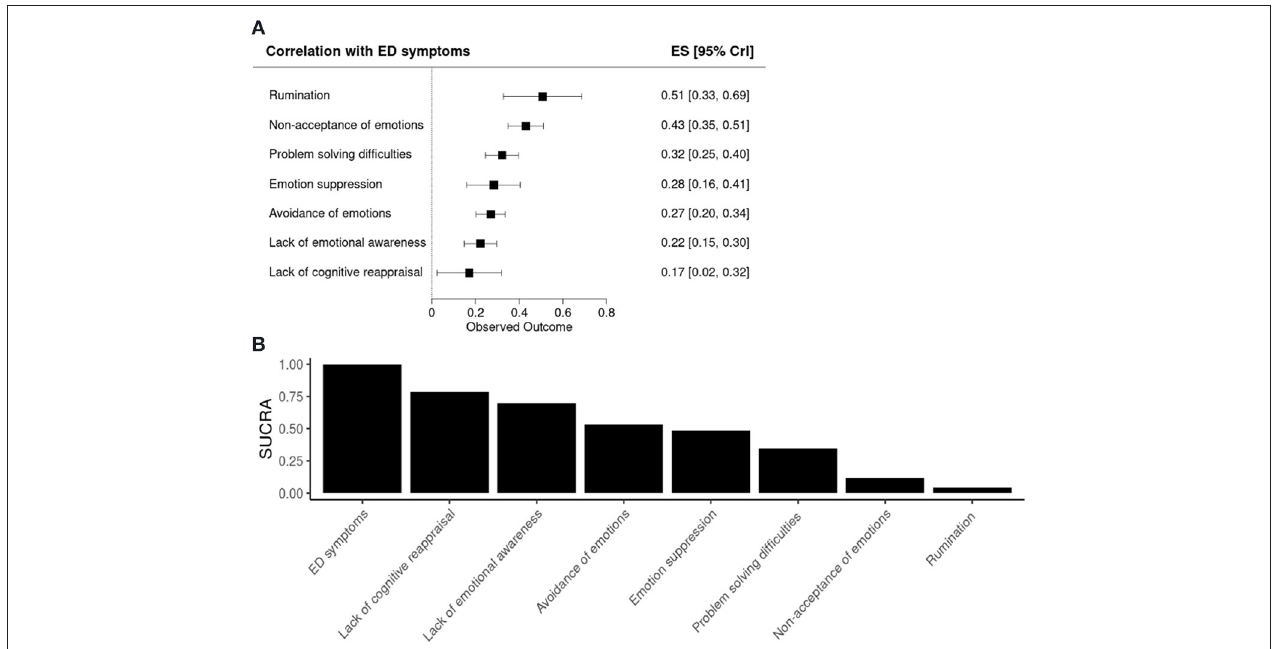
FIGURE 3 | Forest and SUCRA plots. (A) Forest plot showing the associations between the emotion regulation strategies and ED symptoms. (B) Bar plot showing the surface under the cumulative ranking (SUCRA) for each emotion regulation method. ES, effect size; CrI, Credible Interval.